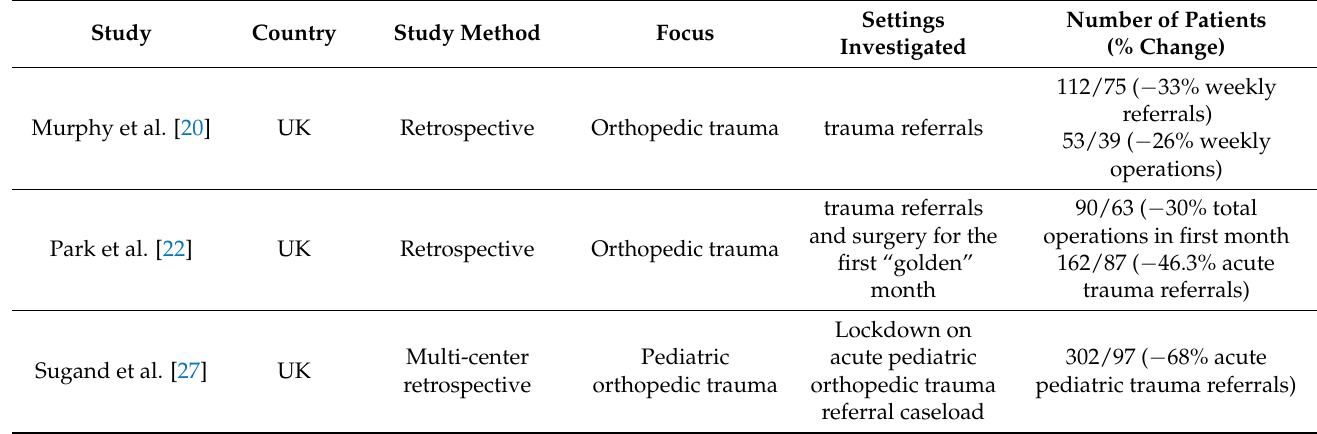
Table 8. Characteristics of relevant publications on orthopedic work loading.